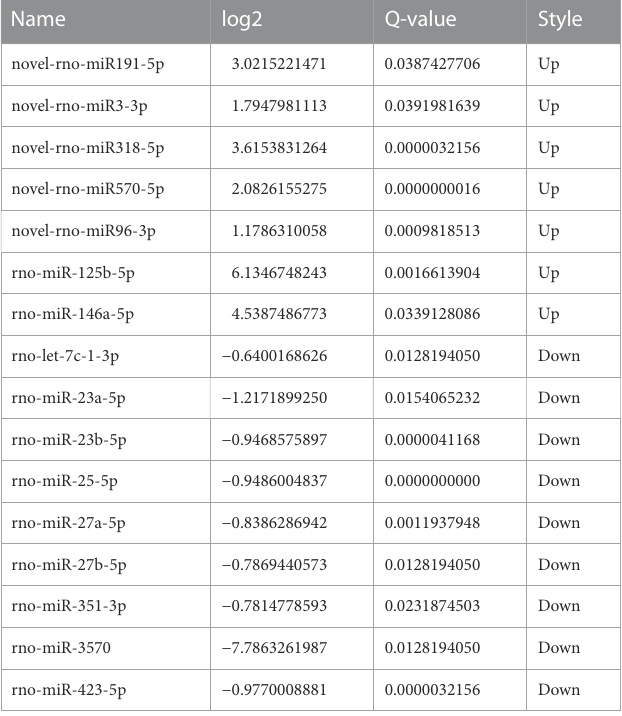
TABLE 4 Data related to differentially expressed microRNAs in the AR/ astaxanthin